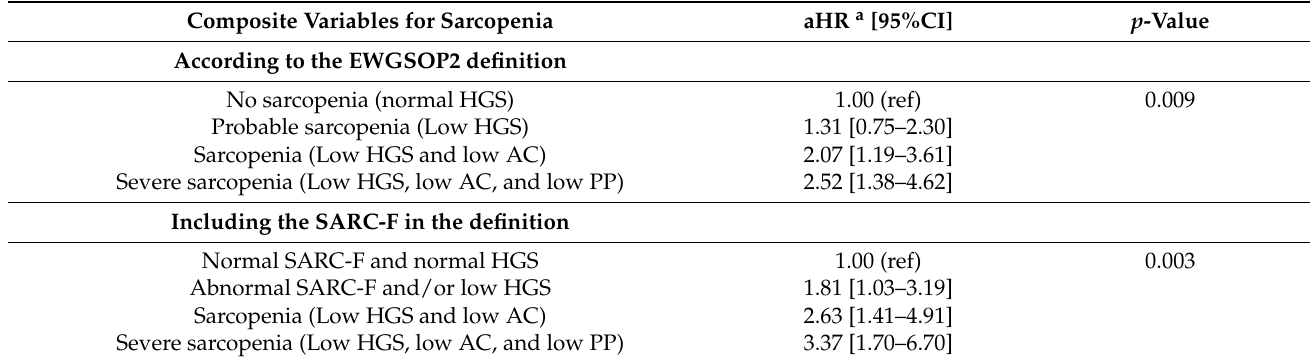
Table 4. Adjusted hazard ratios for two composite variables for sarcopenia and 6-month